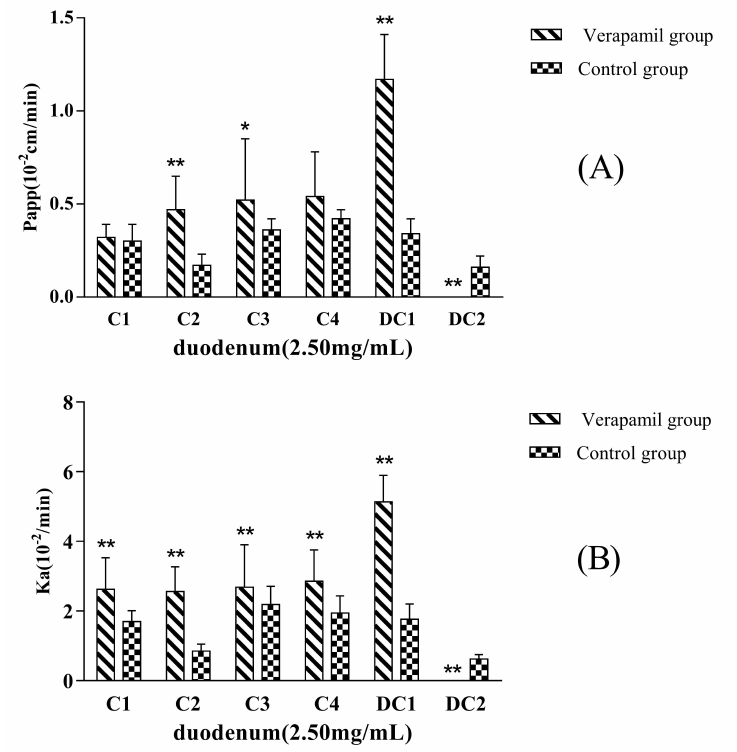
Figure 3. P app ( A ) and K a ( B ) of the six analytes in duodenum obtained after in situ single-pass perfusion of MDQ-TS (2.5 mg/mL) with or without verapamil. The rat duodenum (~10 cm) was used to evaluate the intestinal permeability of MDQ-TS. Data was expressed as mean ± SD of five independent experiments each group. * p < 0.05 versus non-verapamil group; ** p < 0.01 versus non-verapamil